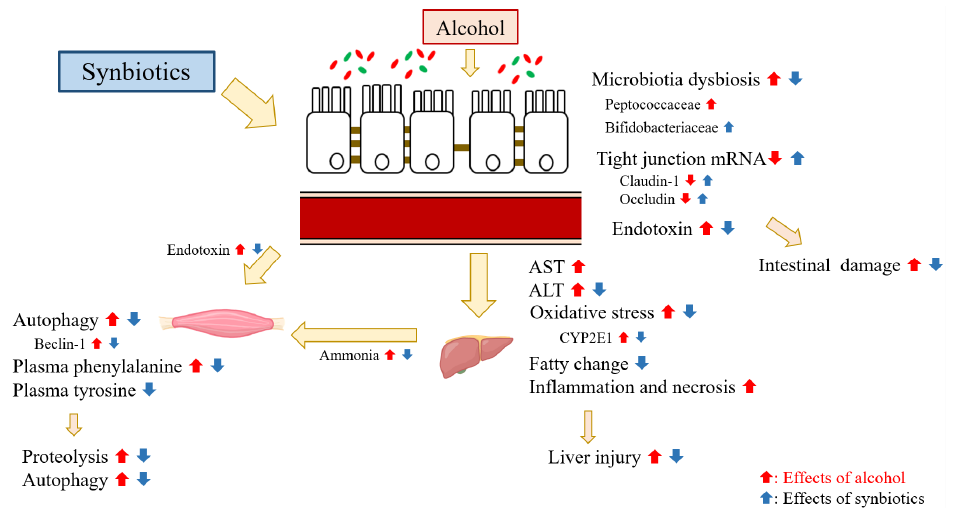
Figure 10. Effects of synbiotics supplementation on inhibition of muscle degradation in rats with chronic ethanol feeding. (1) In this study, it was indicated that synbiotics inhibited the protein degradation in muscle tissue when rats fed with an ethanol-containing diet. (2) The inhibition of muscular protein degradation by synbiotics supplementation may be due to two underlying pathways. First, when rats chronically ingested ethanol, synbiotics maintained the intestinal integrity and well-balanced microbiota composition, thereby reducing the lower plasma endotoxin level, which inhibited muscle damage. Secondly, synbiotics inhibited the elevation of plasma ammonia level and regulated the AAAs metabolism by ameliorating ethanol-induced liver injury based on the gut-liver axis, then reduced the protein degradation in muscle. Table S2: Effects of synbiotics supplementation on hepatic amino acid composition in rats with chronic alcohol feeding, Table S3: Effects of synbiotics on supplementation on muscle amino acid composition in rats with chronic alcohol feeding.